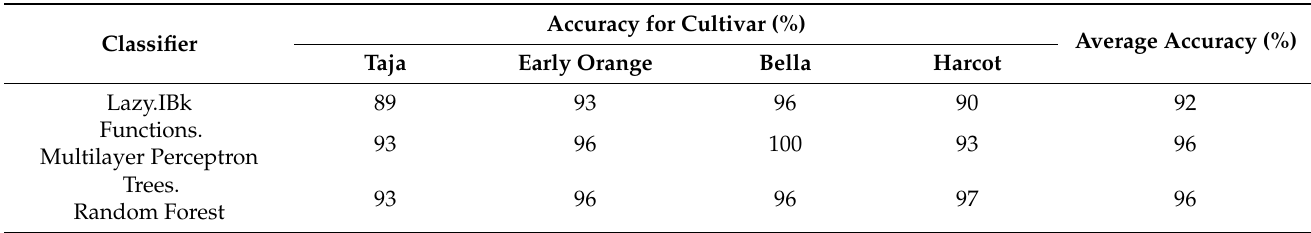
Average Accuracy (%)